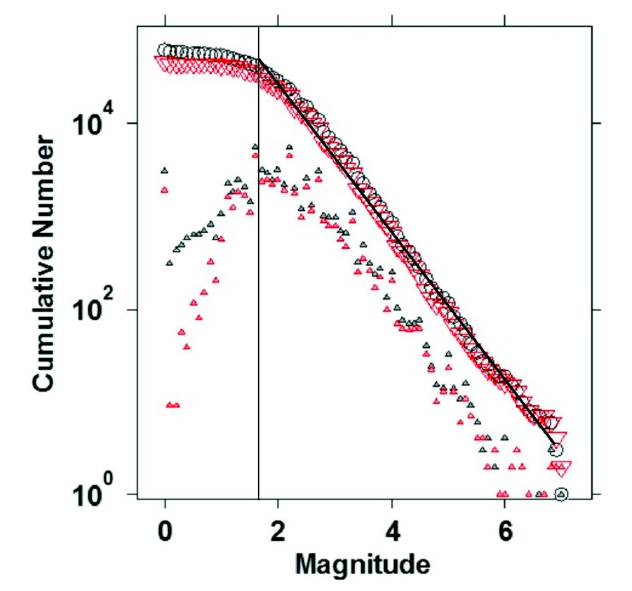
Figure 1. Cumulative Gutenberg–Richter plot of the whole (black circles) and aftershock-depleted (downward red triangles) catalogue of Georgia. The plot shows also the binned frequency–magnitude distribution of the whole (upward black triangles) and aftershock-depleted (upward red triangles) catalogues. The completeness magnitude is around